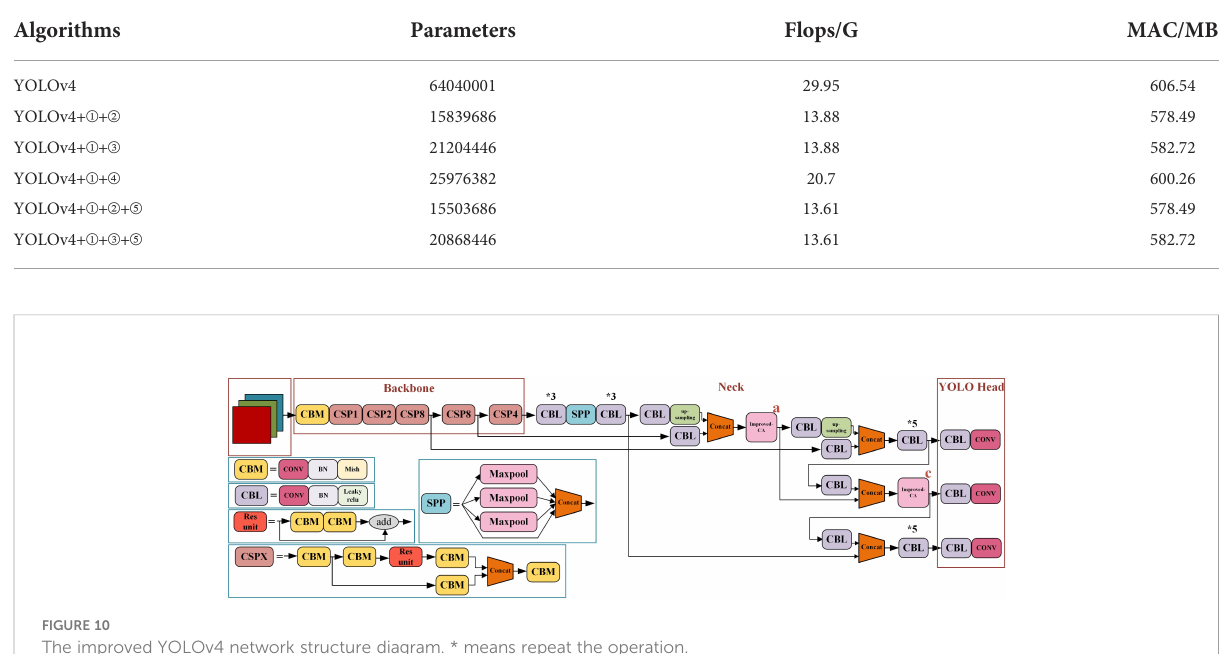
TABLE 3 Comparison results of different improved